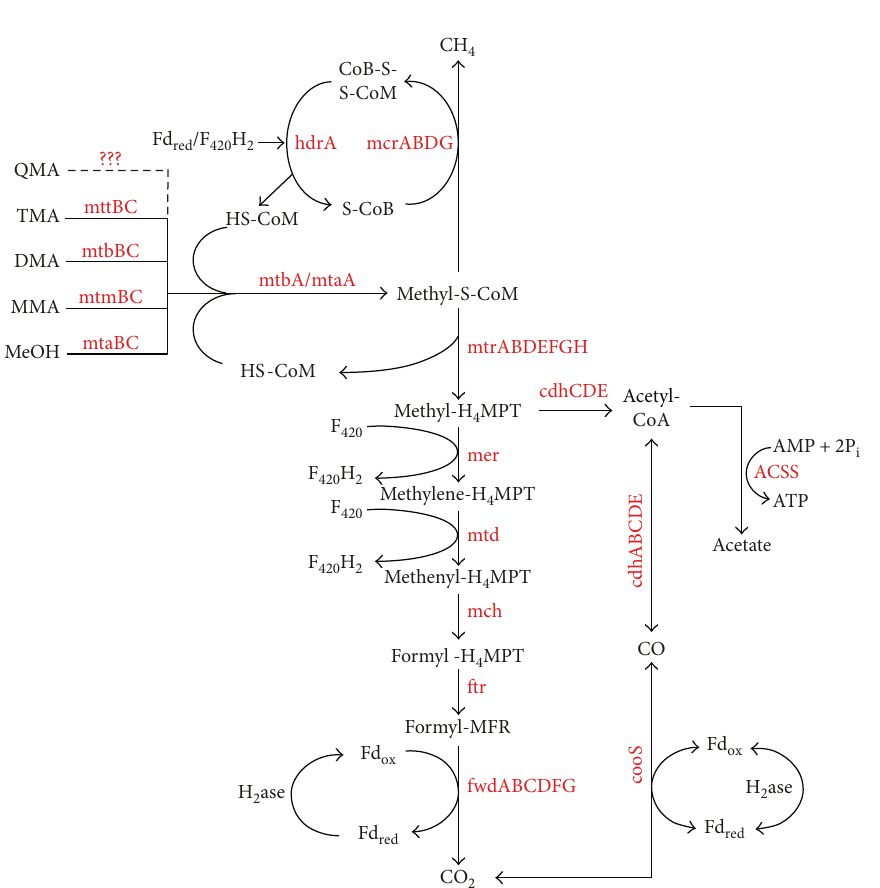
Figure 5: Proteins expressed in the pathways of methylotrophic, hydrogenotrophic, and acetotrophic methanogenesis of Methanomethylovorans hollandica in the conversion of tetramethylammonium (QMA) to methane. TMA: trimethylamine; DMA: dimethylamine; MMA: monomethylamine; MeOH: methanol; MFR: methanofuran; H coenzyme M; HS-CoB: coenzyme B; CoM-S-S-CoB: heterodisul fi de of HS-CoM and HS-CoB; F reduced ferredoxin; Fd : oxidized ferredoxin; H ase: hydrogenase. The proteins detected in the study were highlighted in red and referred ox 2 to in Table